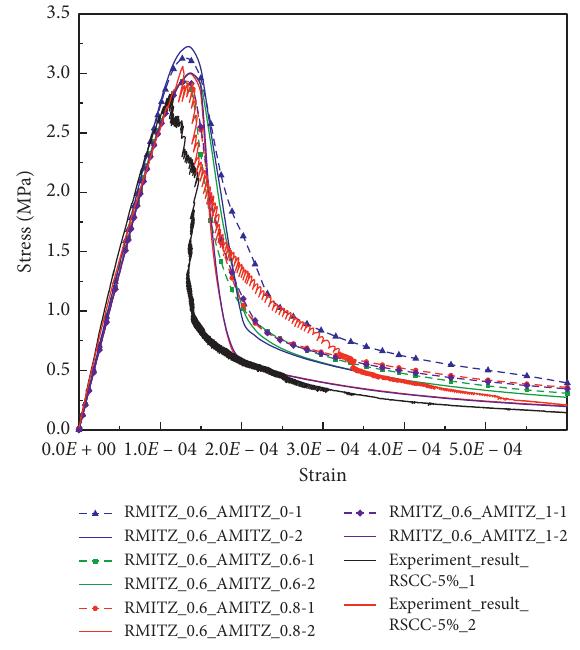
Figure 11: Stress-strain curves of varying thickness A-M ITZs models.